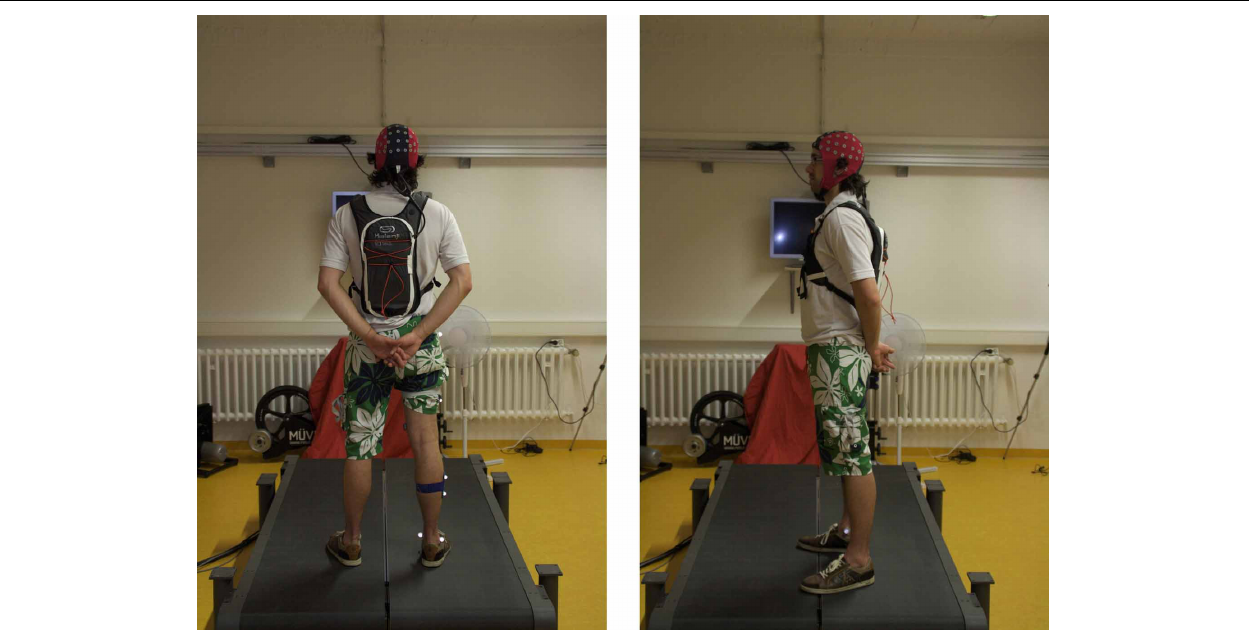
FIGURE 7 | ANT-Neuro eegosports™ wireless EEG system. Left: Posterior view: A study participant wearing the EEGOSPORTS WaveGuard EEG cap. The cap cable goes inside the backpack where it connects to the amplifier and Ultrabook. Right: Lateral